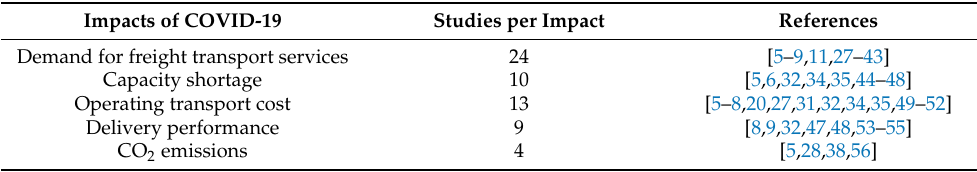
Table 4. Categorization of different impacts of COVID-19 on freight transport. Impacts of